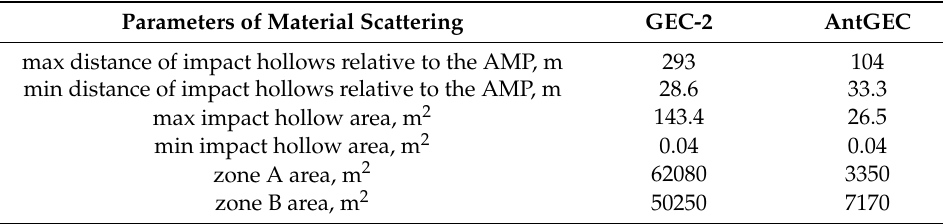
Table 4. Different parameters of impact hollows and scattering zones around GEC-2 and AntGEC. Parameters of Material Scattering max distance of impact hollows relative to the AMP, m min distance of impact hollows relative to the AMP,